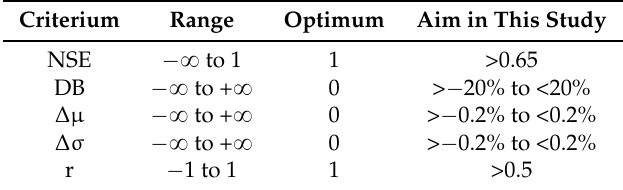
Table 3. Description of performance criteria used in this study to evaluate model results.